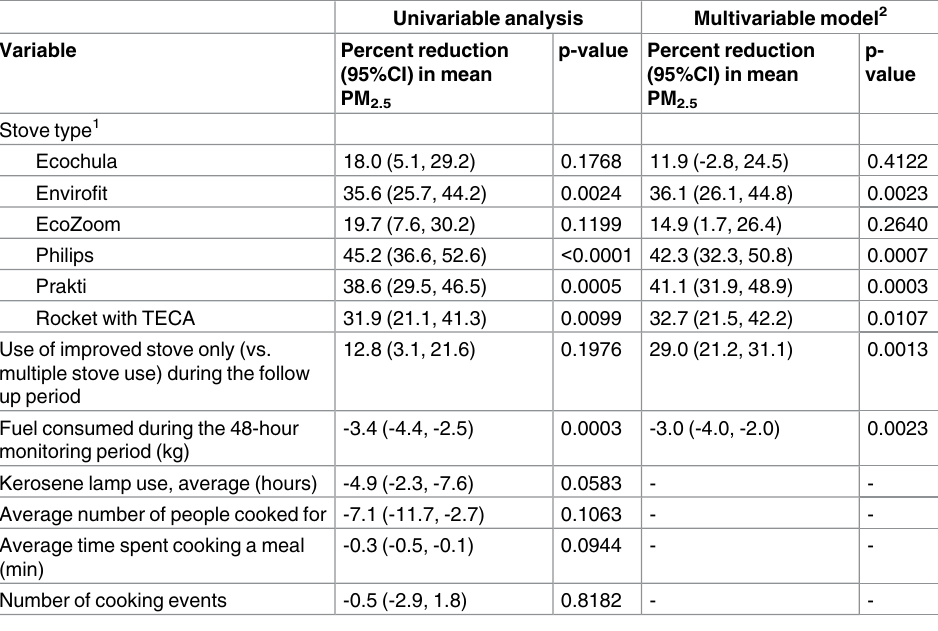
Table 4. Factors associatedwith 48-hour mean gravimetric PM 2.5 ( μ g/m 3 )